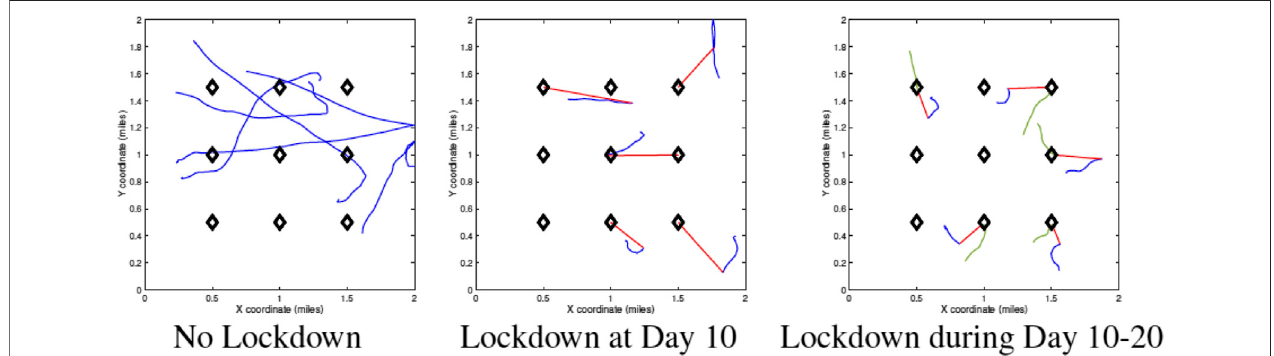
FIGURE 3 | Sample agent motions under different conditions. Blue curves denote unrestricted movements, red curves denote movement toward home units during a lockdown, and green curves denote movement after